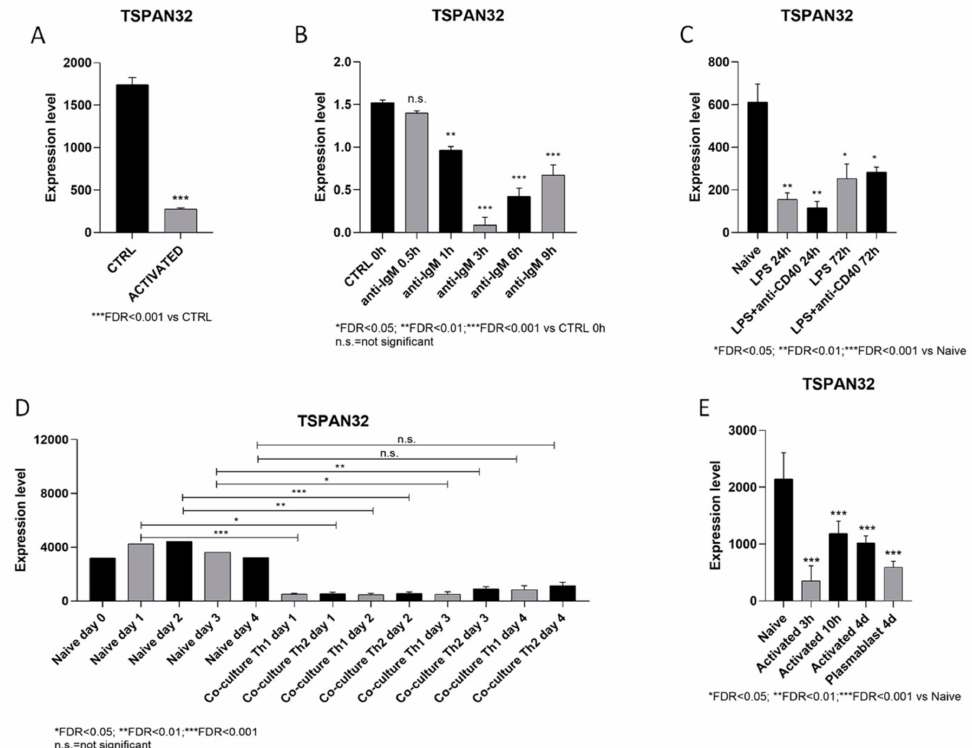
Figure 1. Modulation of TSPAN32 expression in B cells following activation. The transcription levels of TSPAN32 during the activation of B cells were evaluated using the publicly available GSE15606, GSE20477, GSE35998, GSE84948, and GSE147497 datasets. ( A ) TSPAN32 expression levels in murine primary B-lymphocytes purified from spleens and stimulated with IL-4 (5 ng/mL) and CD40L (200 ng/mL) and anti-mouse IgM (2.5 µ g/mL) for 3 h were obtained from the GSE15606 dataset. ( B ) TSPAN32 expression data in primary B lymphocytes stimulated with 10 µ g/mL anti-IgM for 30 min, then incubated for 0.5, 1, 3, and 6 h were retrieved from the GSE20477 dataset. ( C ) TSPAN32 gene expression profiles of naïve B cells, B cells activated with LPS, and B cells activated with LPS + anti-CD40 for 24 and 72 h were obtained from the GSE35998 dataset. ( D ) TSPAN32 levels in B cells cultured in the presence of either Th1 or Th2 polarized CD4 + T cells for 1–4 days were retrieved from the GSE84948 dataset. ( E ) TSPAN32 expression data in B cells activated with LPS and collected at 3 and 10 h post-stimulation, as well as data from expanded activated B cells and plasmablasts collected at day 4 post-stimulation were retrieved from the GSE147497